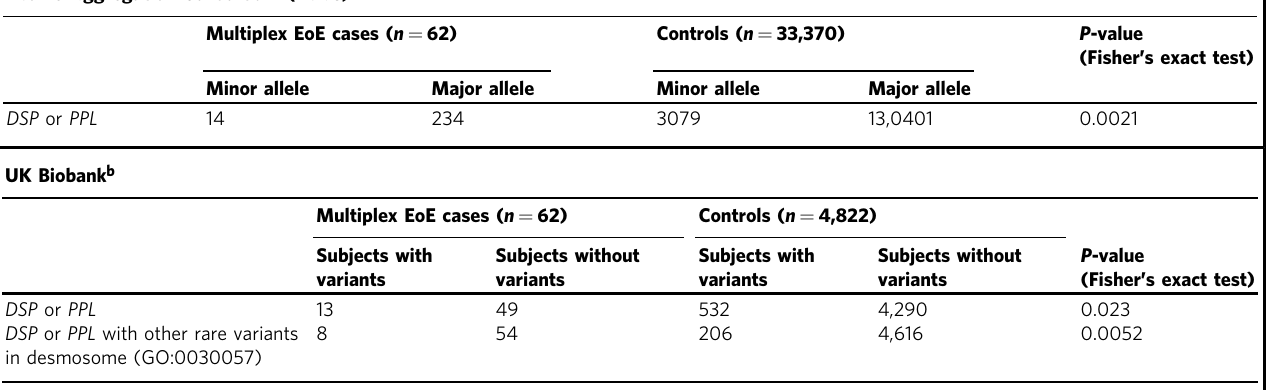
Table 2 DSP or PPL rare variant burden analysis in eosinophilic esophagitis